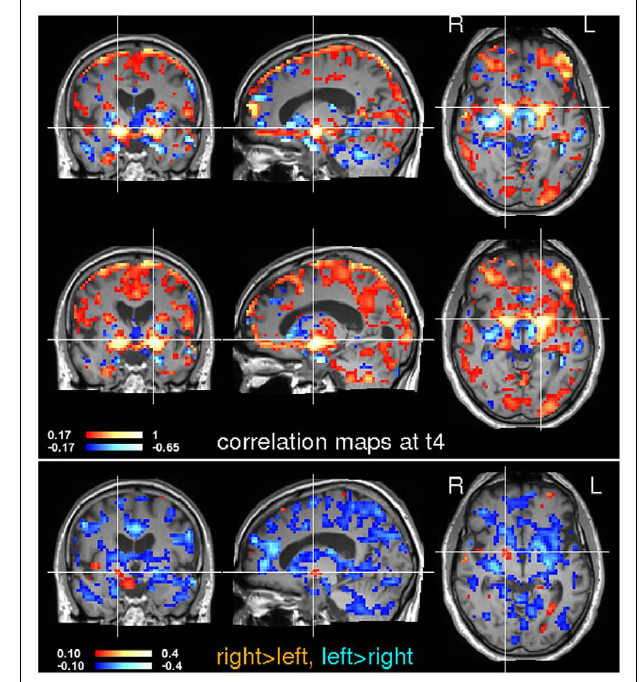
FIGURE 8 | Seed-based correlation analysis at time t3. Voxels in the left and right globus pallidus were used for a subsequent seed-based correlation analysis.The location of the seeds is indicated by the crosshairs. Inter-hemispheric differences are shown in the bottom image. Note that the right globus pallidus generally shows stronger correlations than the left.